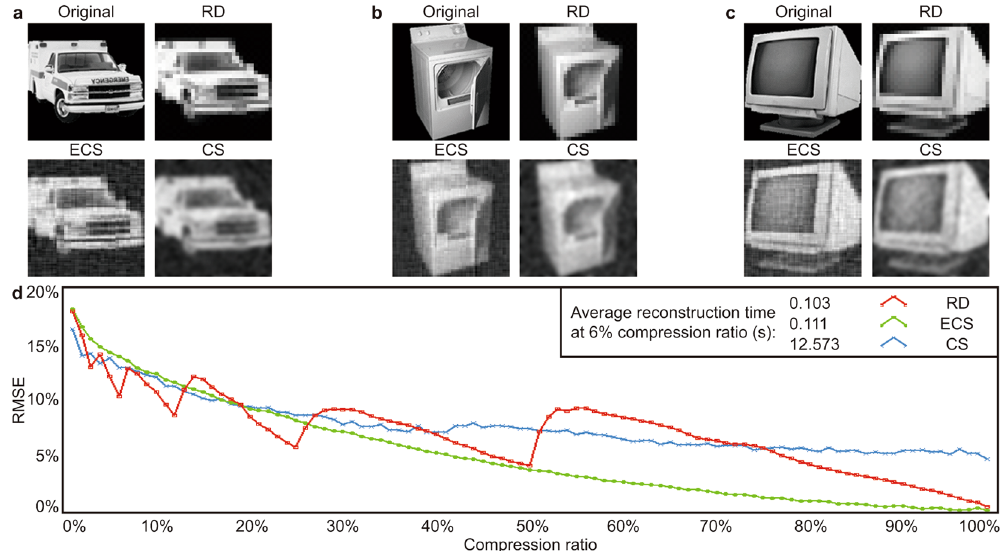
Figure 3. Single object reconstruction comparison. ( a – c ) Examples of single objects (Original), the reconstructed images using ‘Russian Dolls’ approach (RD), evolutionary compressive sensing (ECS), and conventional compressive sensing (CS). ( d ) Comparison based on relative error per pixel as a function of sampling ratio. Average reconstruction times at 6% sampling ratio for three approadches are given as